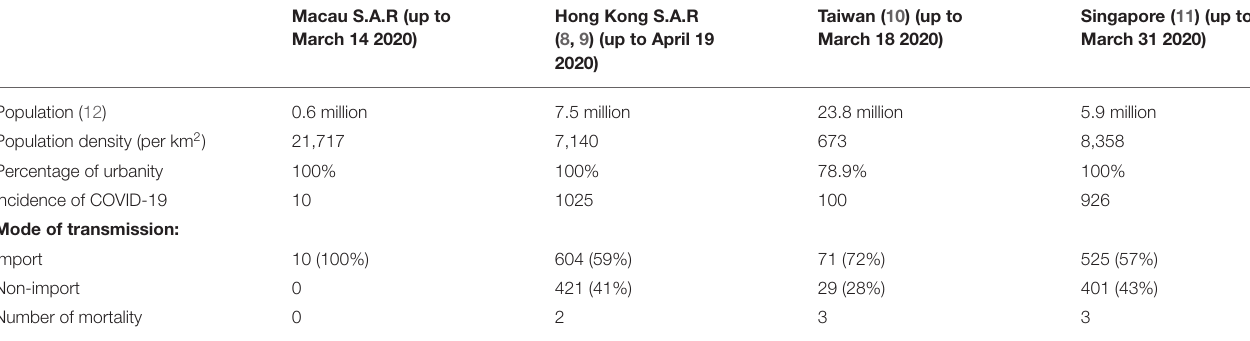
TABLE 2 | Comparison of epidemiology and demographics of cases of COVID-19 in Macau with neighboring regions during the initial phases of the